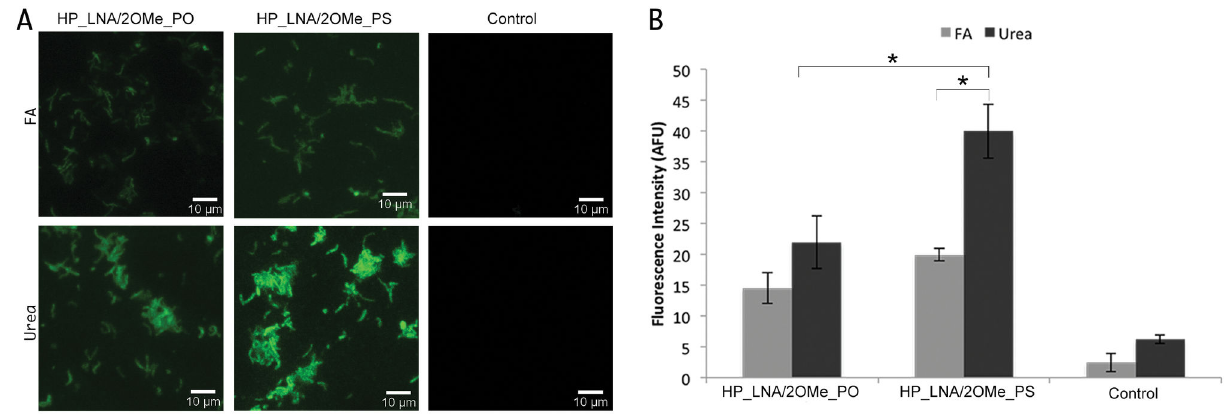
Figure 2. FISH detection of H. pylori 26695 strain (ATCC 700392) using FAM- HP_LNA/2OMe_PO and HP_LNA/2OMe_PS probes. FISH analysis was performed by epifluorescent microscopy in smears, using either 50% (vol/vol) formamide and 4 M urea as denaturing agents in the hybridization buffer. Smears without probe were used as negative control (Control) (a). (2B) Average fluorescence intensity from each probe in 4 M urea and 50% formamide (v/v) buffers; fluorescent signal intensity is expressed in arbitrary fluorescent units (AFU) and was quantified using the by ImageJ software. All images were acquired at equal exposure conditions. Original magnification: